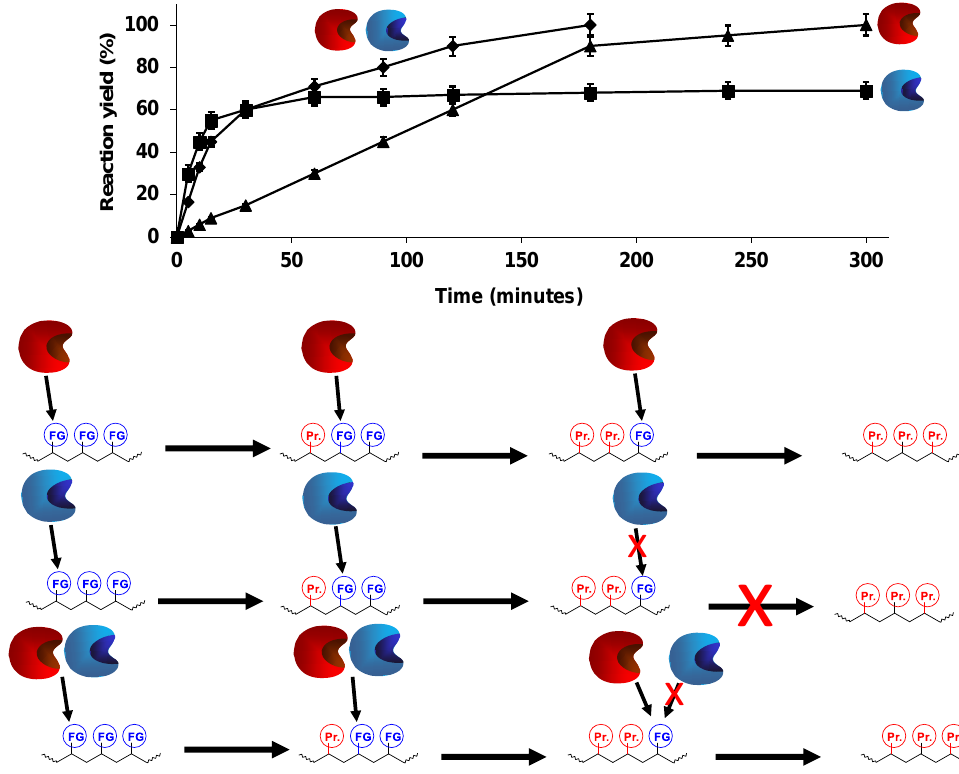
Figure 7. Solving the problem of product inhibition by using mixtures of several enzymes, one with high activity and high product inhibition, and the other with lower activity but not inhibited by the product.